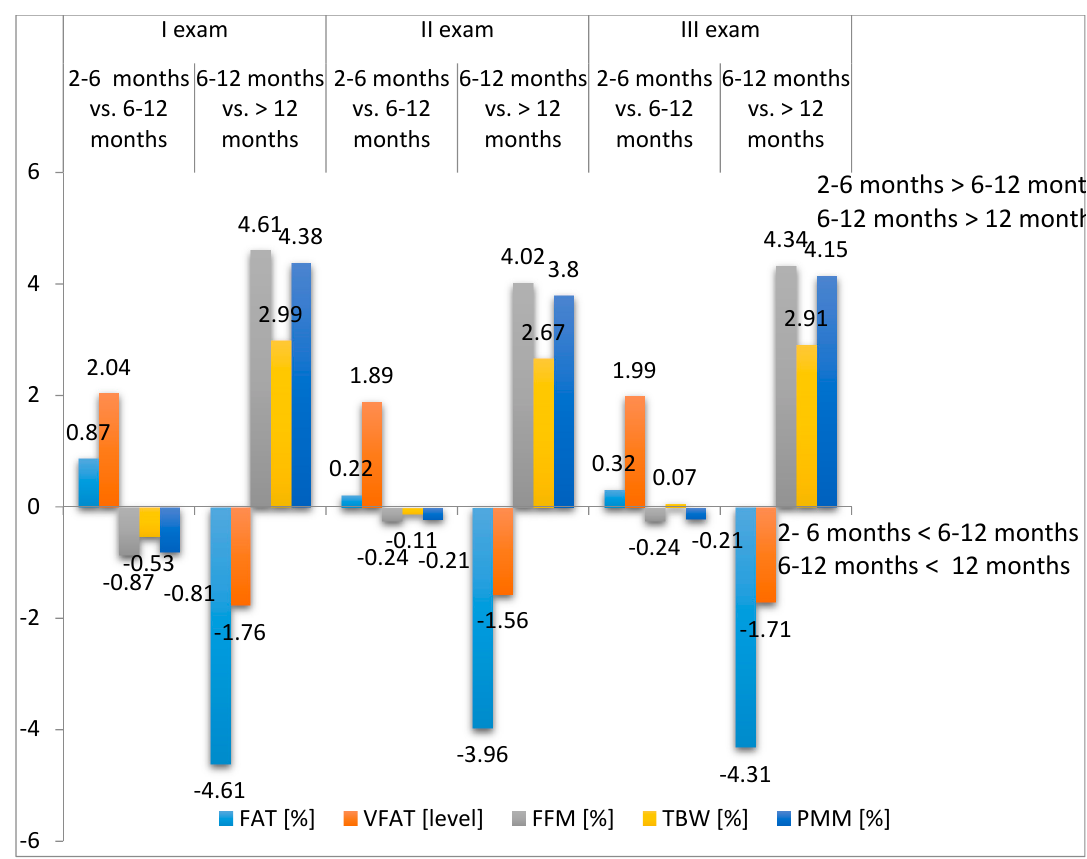
Figure 4. Difference between body mass components versus time from onset of the first stroke Figure4. Di ff erencebetweenbodymasscomponentsversustimefromonsetofthefirststrokesymptoms. symptoms.